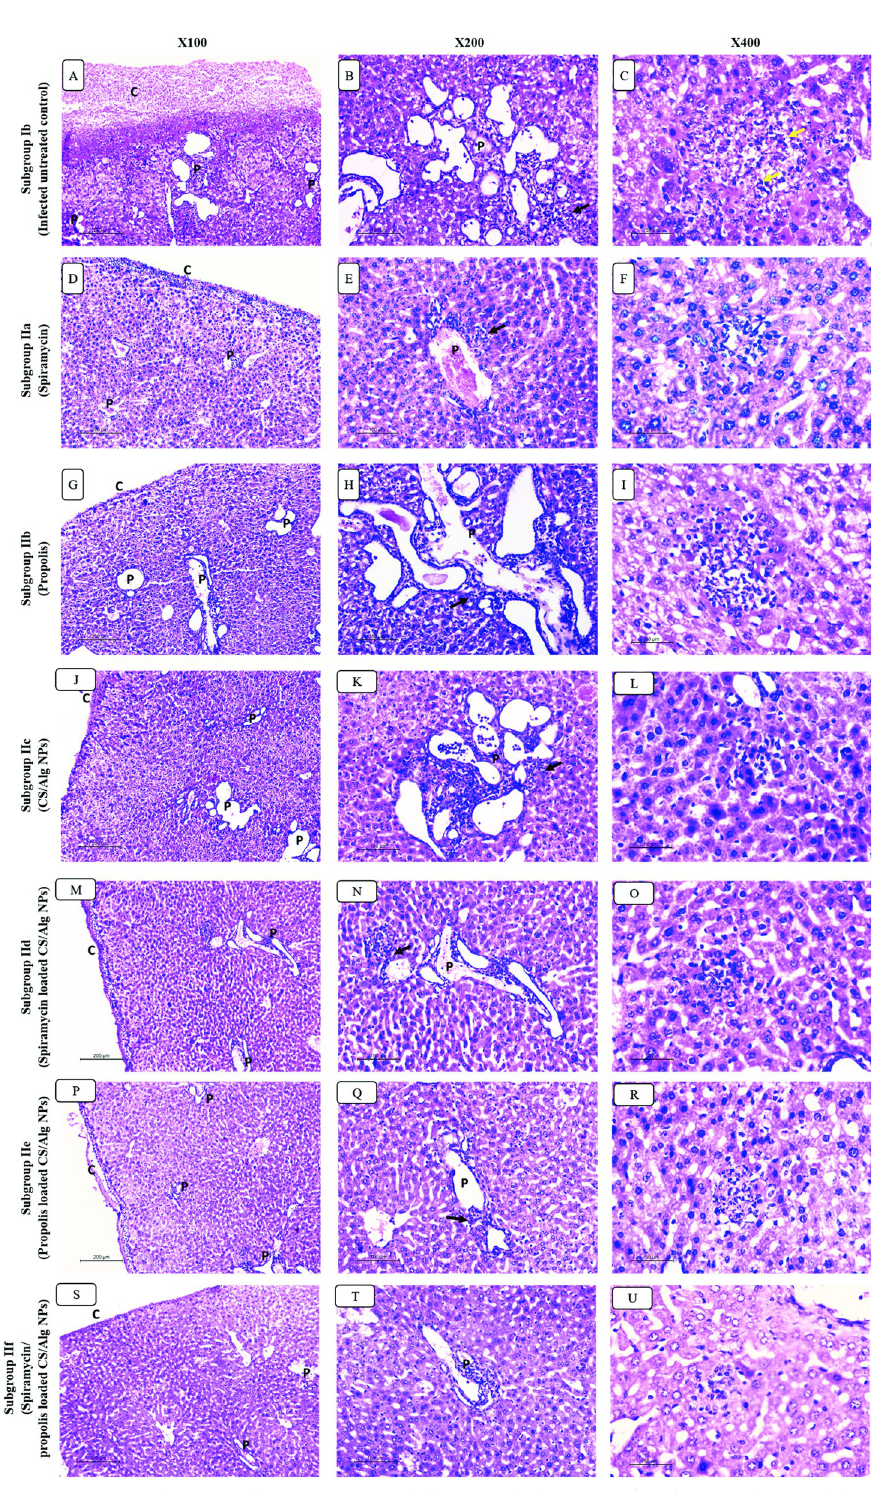
Fig 8. H&E-stained sections of hepatic tissues in different studied groups. Infected untreated group: (A) Severe capsular oedema and dense inflammatory exudate is seen on liver capsule (c) and diffuse severe portal inflammation (P). (B) Portal tract (p) showing severe mononuclear inflammation with interface hepatitis (black arrow) and marked vascular congestion. (C) Large mononuclear lobular inflammation focus showing necrotic hepatocytes and numerous parasites (yellow arrow). Spiramycin treated group: (D) Moderate capsular oedema with mild inflammatory exudate